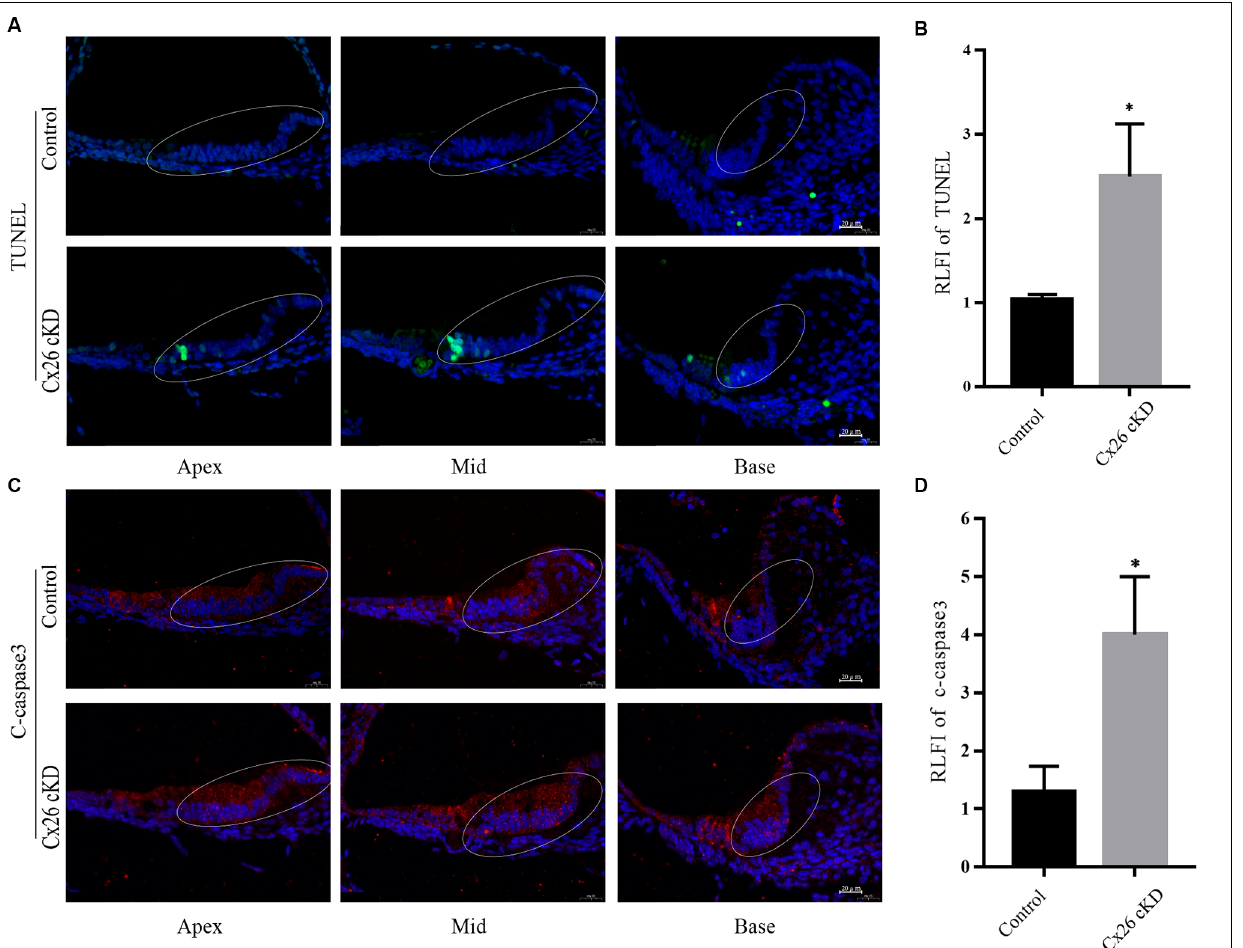
FIGURE 2 | Apoptosis of Kölliker’s organ was detected by immunofluorescence staining at P1. (A) Representative confocal fluorescence images showing TUNEL positive cells (green) in Kölliker’s organ of the Cx26-cKD group, but not in the control group. Blue signals correspond to cell nuclei stained with DAPI. Scale bars = 50 µ m. (B) Average relative fluorescence intensity (RLFI) of TUNEL signals; ∗ represent p < 0.05, n = 3. (C) Immunofluorescence staining of cleaved (c)-caspase 3 in the apical, middle, and basal turns of Kölliker’s organ cells of Cx26-cKD group compared with the control group. Scale bars = 50 µ m. (D) Average relative fluorescence intensity (RLFI) of the c-caspase 3 signal; ∗ represents P < 0.05, n =